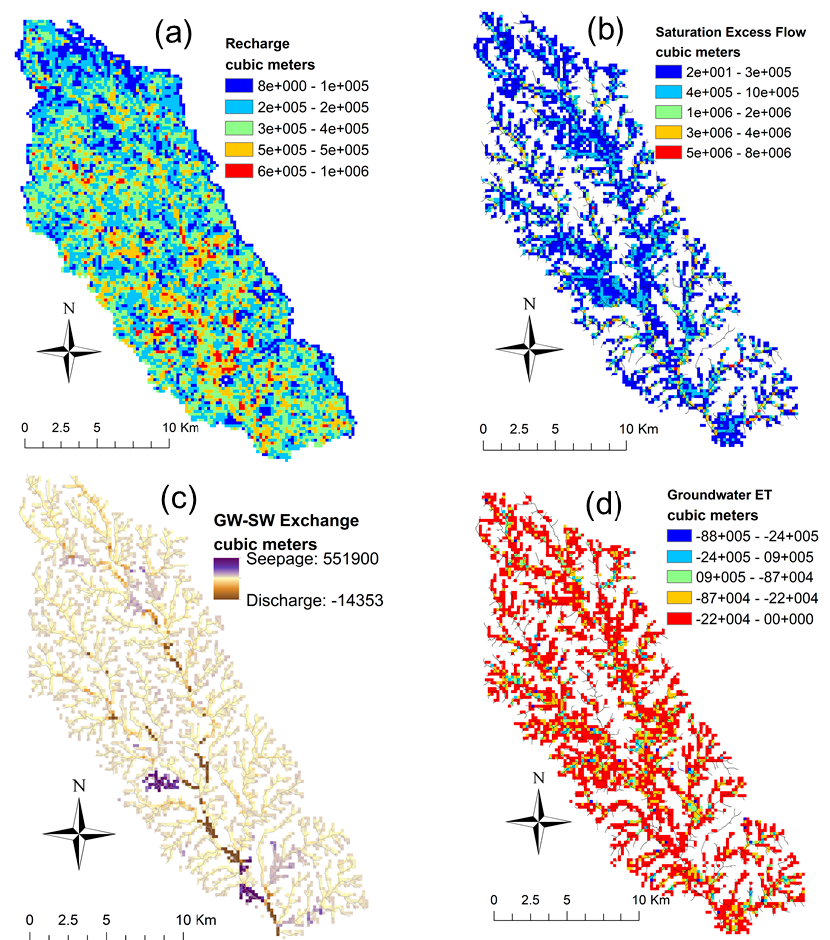
Figure 9. Maps of total volume (m 3 ) of groundwater stress flux for the 1980-2013 simulation period: ( a ) recharge, ( b ) lateral flow, ( c ) groundwater–surface water exchange, ( d ) groundwater ET, and (e) saturation excess flow.